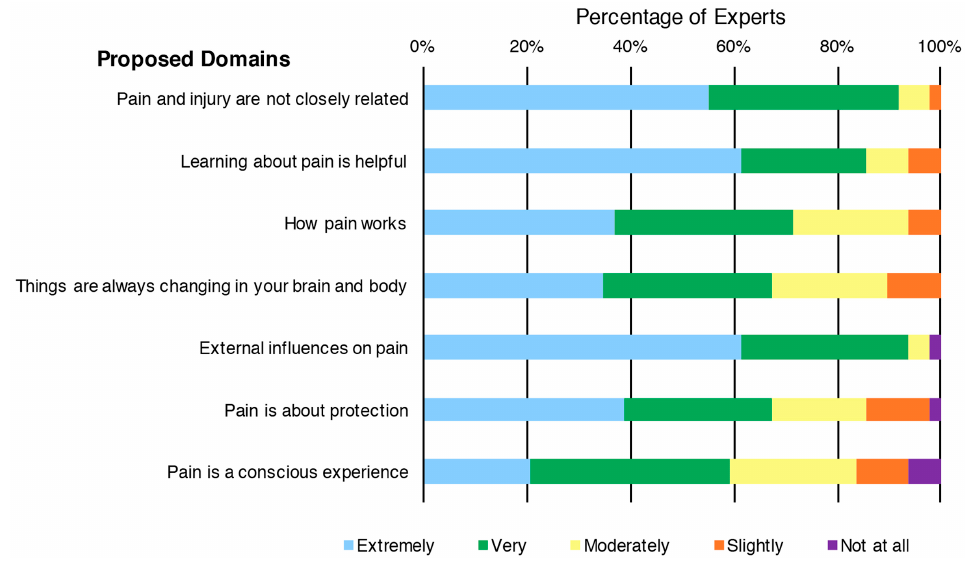
Figure 4. Distribution of pediatric pain experts’ ratings of the importance of the Proposed Domains for a child’s concept of pain, sorted by ratings.